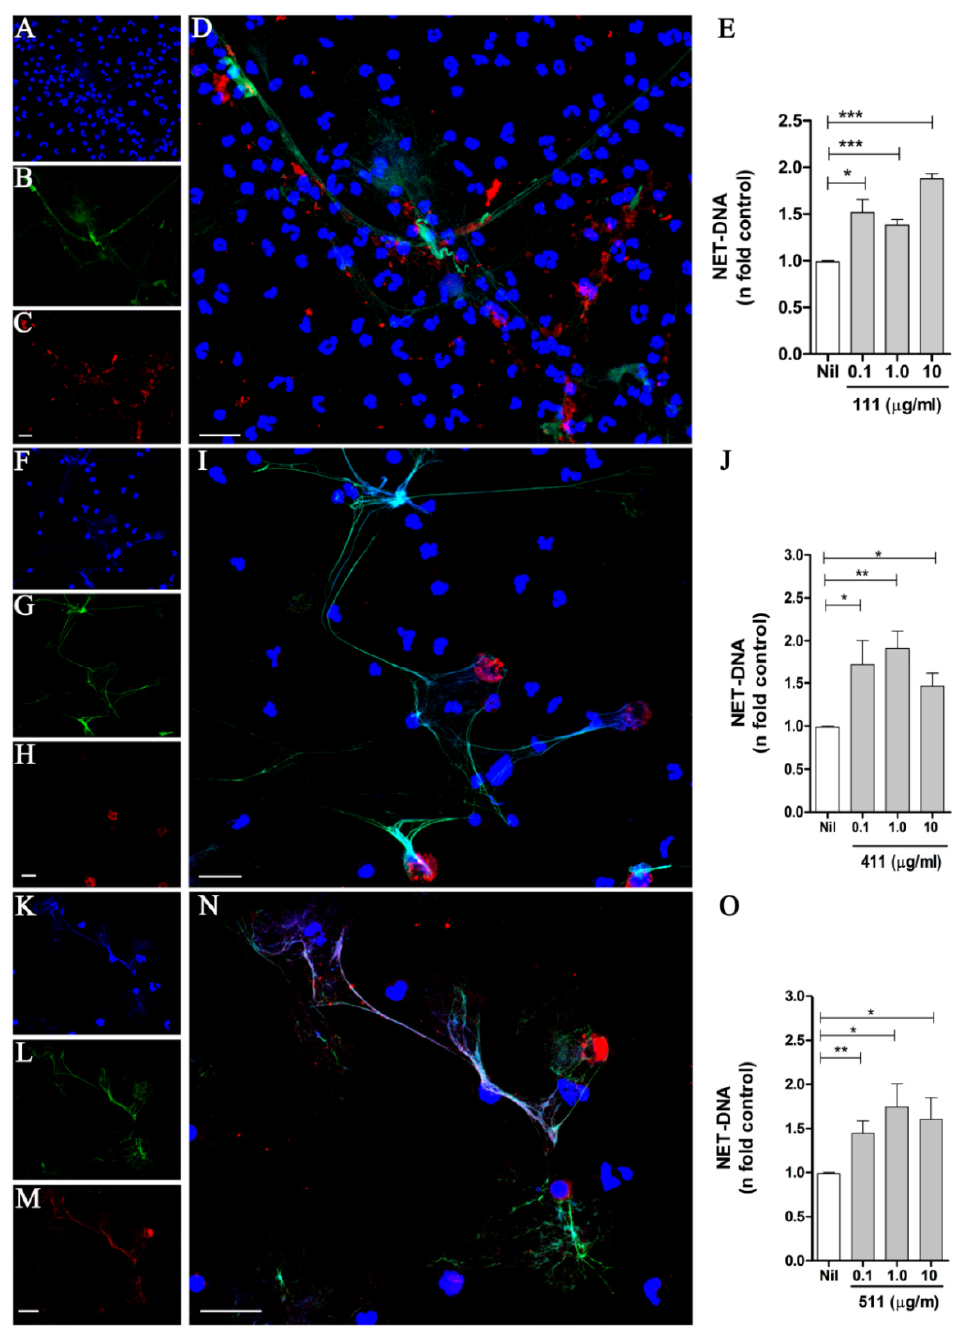
Figure 1. Laminin isoforms 111, 411, and 511 induce NET release. Neutrophils were incubated with the LM isoforms 111 ( A – D ), 411 ( F – I ), and 511 ( K – N ) at 1 µg/mL for 90 min. The cells were then fixed and stained for detection of DNA (with DAPI) ( A , F , K ), elastase ( B , G , L ), and LM isoforms 111, 411, and 511 ( C , H , M ). Enlarged images show merged staining for LMs 111 ( D ), 411 ( I ), and 511 ( N ). Bars: 20 µm. NETs in neutrophil culture supernatants stimulated with LMs 111 ( E ), 411 ( J ), and 511 ( O ) for 90 min were quantified using PicoGreen. The data were normalized according to spontaneous release of DNA (Nil) and are represented as the mean ± SEM of 4 experiments ( E , J , O ). * p < 0.05; ** p < 0.004. *** p < 0.001.